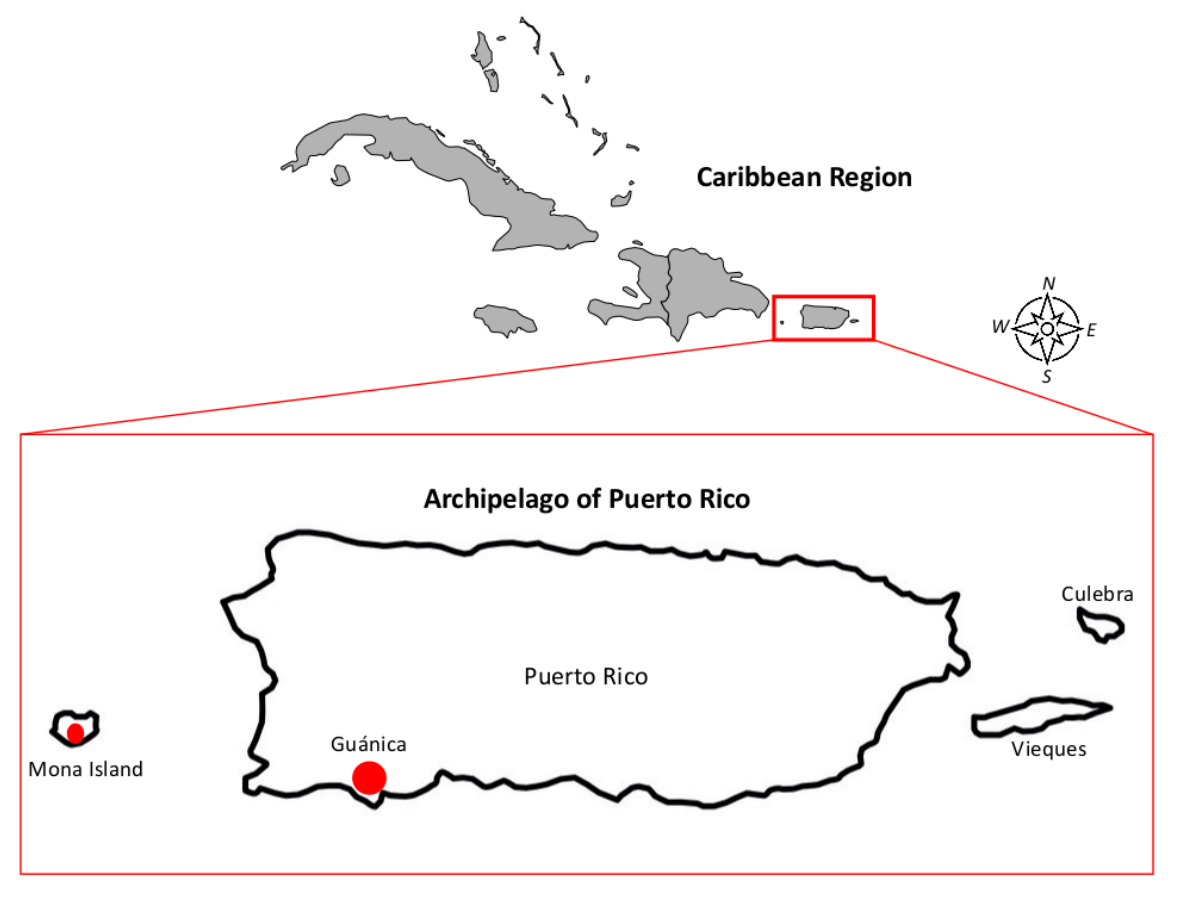
Figure 1. Map of the Caribbean region showing the location of the Archipelago of Puerto Rico and the location of the two islands used as study sites (red